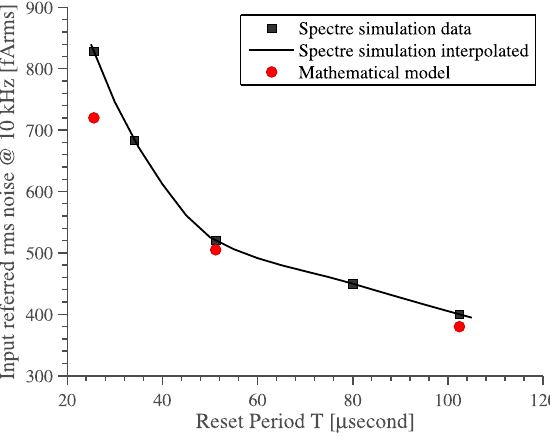
Figure 10. Effect the reset period T on the input-referred r.m.s. noise. Comparison of the proposed mathematical model with SpectreRF ® pss-noise analysis.